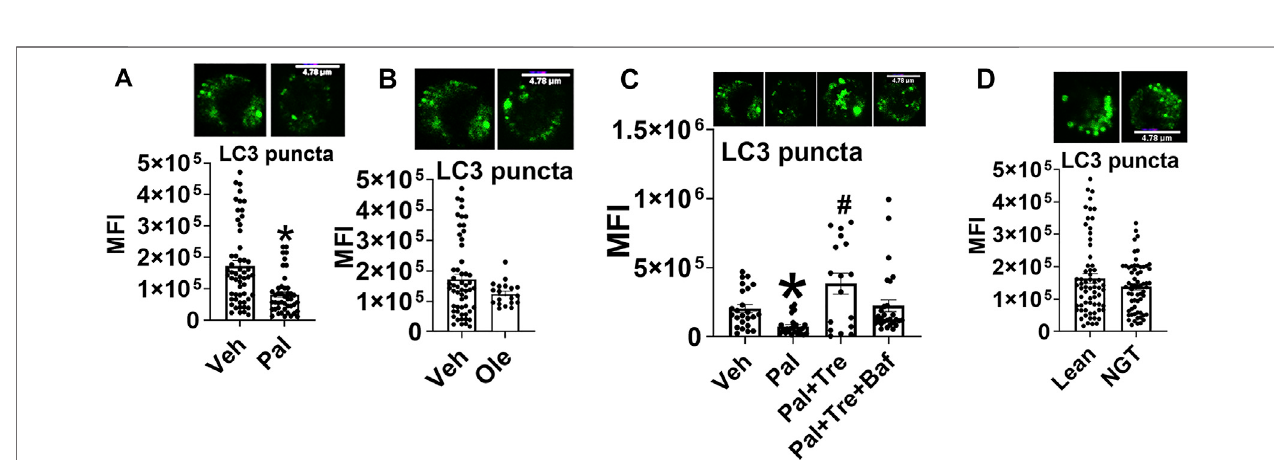
FIGURE 5 | Trehalose does not impact palmitate-induced p-Ser 727- STAT3 and mitochondrial translocation by promoting autophagy. (A) LC3 puncta after palmitate, (B) oleate, (C) autophagy fl ux analysis, and (D) puncta in cells from NGT subjects N = 3 – 4. Each N represents cells obtained from one subject. At least 7 – 10 fi eldsperslidewereimagedat63×magni fi cationwithoilimmersion,onaZeissLSM800confocalmicroscope.In fi eldswherenumerouscells/ fi eldswereobserved, the averages are plotted. The brightness of the images was enhanced to improve clarity. * p < 0.05 vs. Veh, # p < 0.05 vs. Pal.